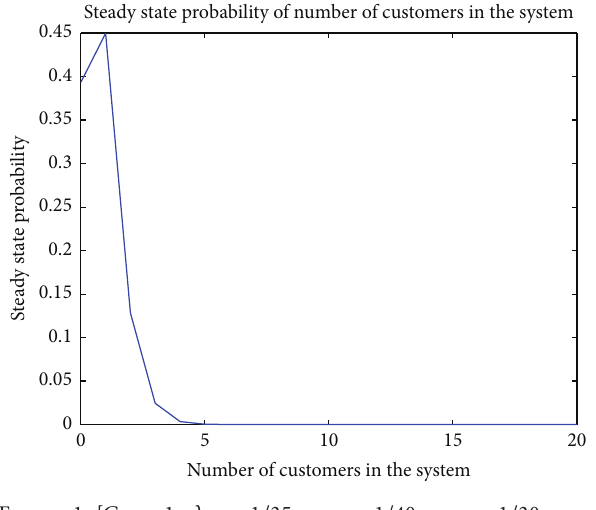
Figure 1: [𝐶 = 1, 𝜆 = 1/35, 𝜇 1 = 1/40, 𝜇 2 = 1/30, 𝜇 = = 5, 𝐾 = 7] . 1/20, 𝐾 1 2